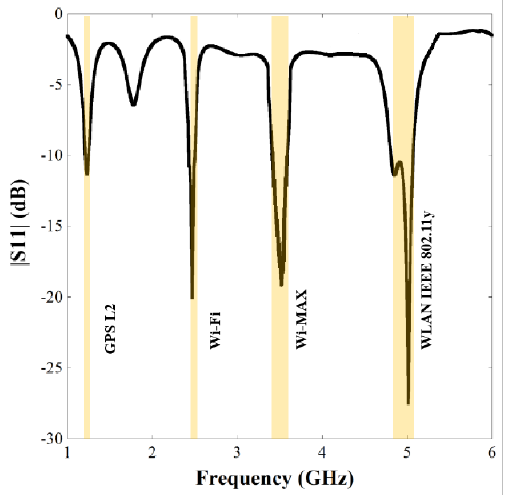
Figure 6. |S11| graph of the single unit meander line antenna. Table 3. Comparison chart between calculated and simulated resonant frequencies of single unit meander-line